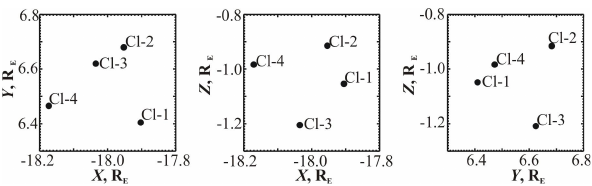
Fig. 1. Cluster position in the GSE coordinate system between 08:15–08:30UT on 22 September